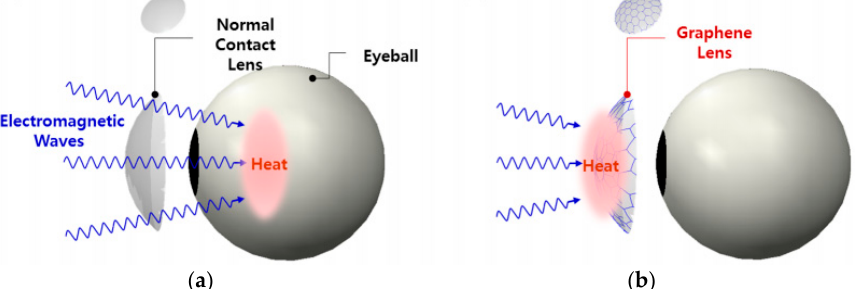
( b ) Figure 6. A graphene-based harmonic sensor on a soft contact lens. ( a ) Schematics of a fully pas-